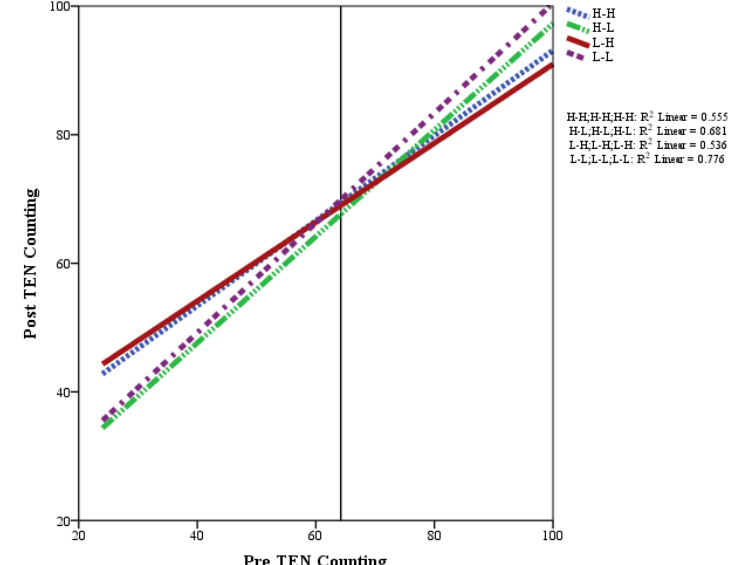
Figure 3 . Students’ performance on the counting task of the Test of Early Numeracy (TEN) with reference line at mean, Y =